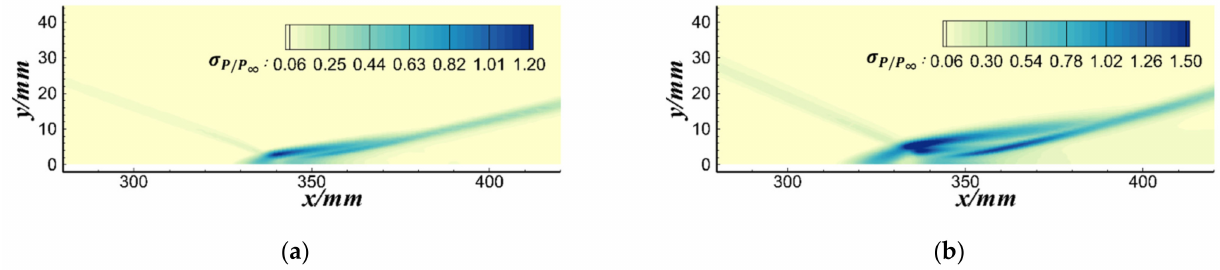
Figure 7. Standard deviation of Mach number contour for the two cases. ( a ) θ = 10 ◦ ; ( b ) θ = 14 ◦ .